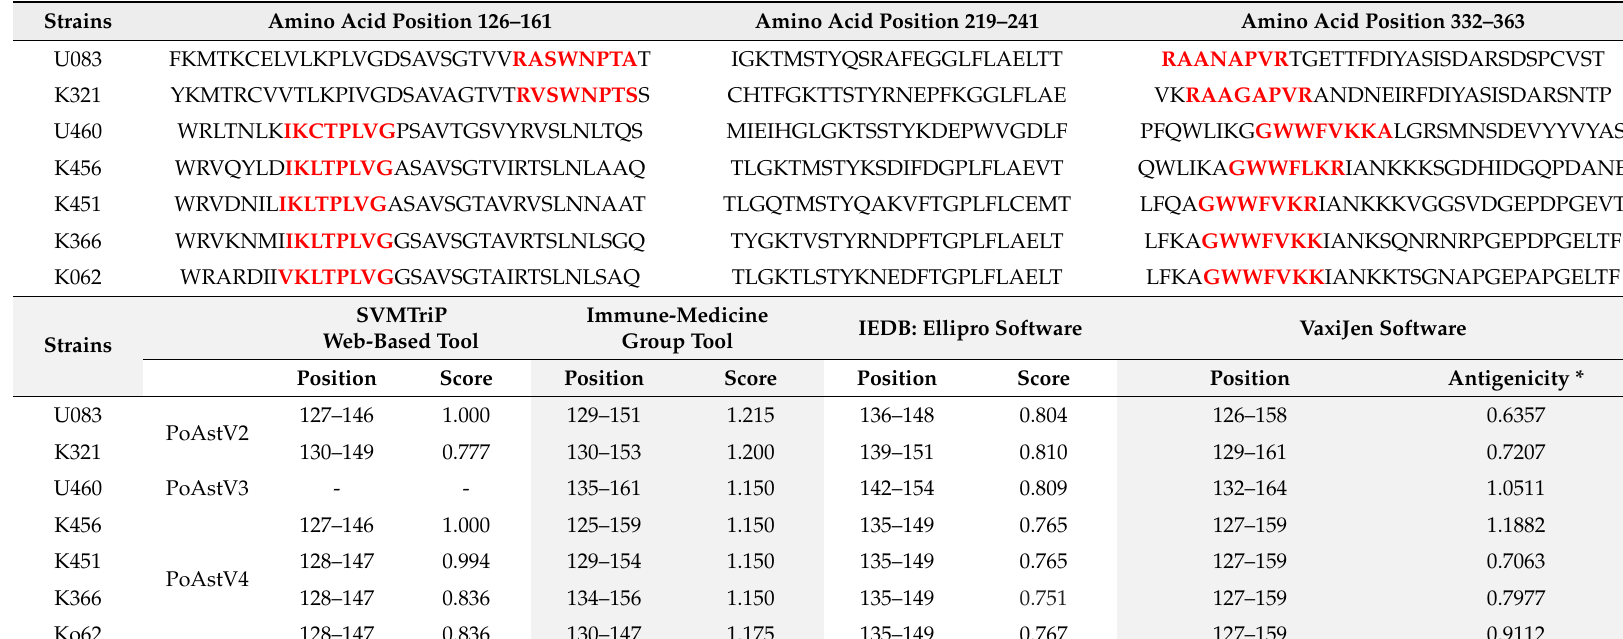
Table 3. Predicted antigenic epitopes within capsid proteins (ORF2) of our field strains using three di ff erent pieces of software, and antigenicity of the predicted epitopes